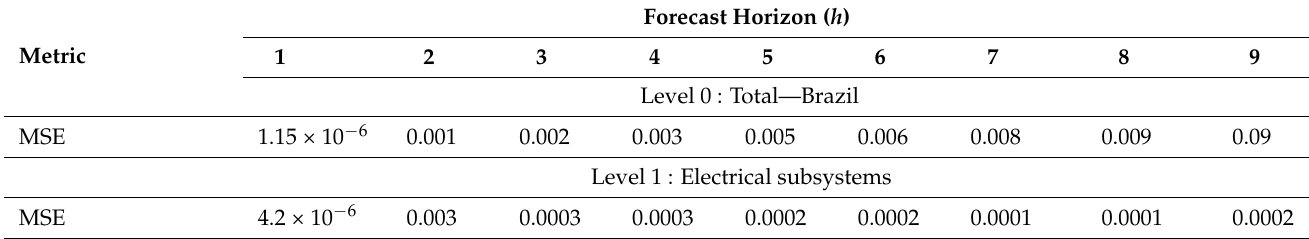
Table 5. Hierarchical forecasting for Brazilian power generation: Coherence performance metric.